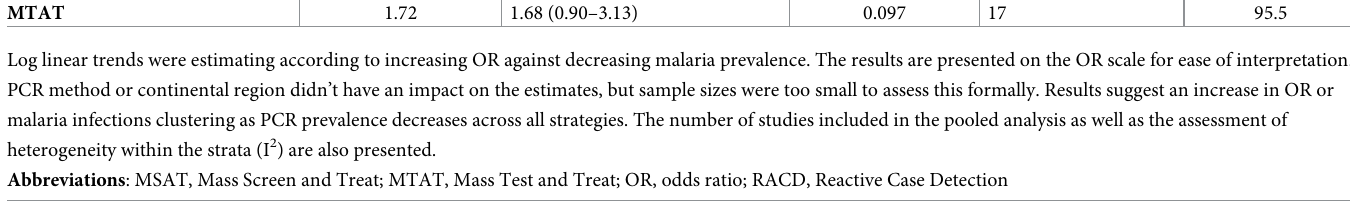
Table 3. Results of the linear regression modelling for each of the 3 strategies assessed, including the neighbor and community controls for the RACD strategy. Strategy Intercept